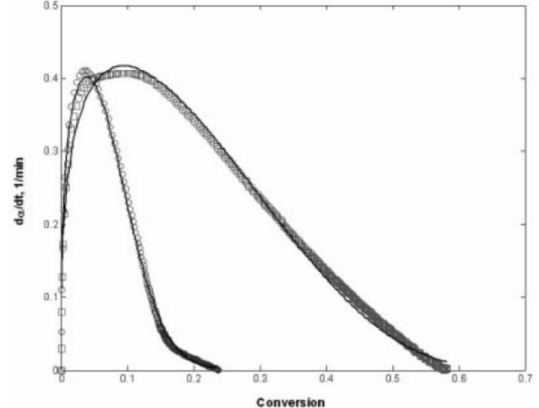
Figure 24. Comparison of experimental data and autocatalytic model of the cationic photopolymer- ization of ECH for different temperatures: Experimental data at 30 ◦ C ( ◦ ), experimental data at 70 ◦ C ( (cid:3) ), and prediction of the autocatalytic model (solid line). Reprinted from reference [29] with the permission of John Wiley and